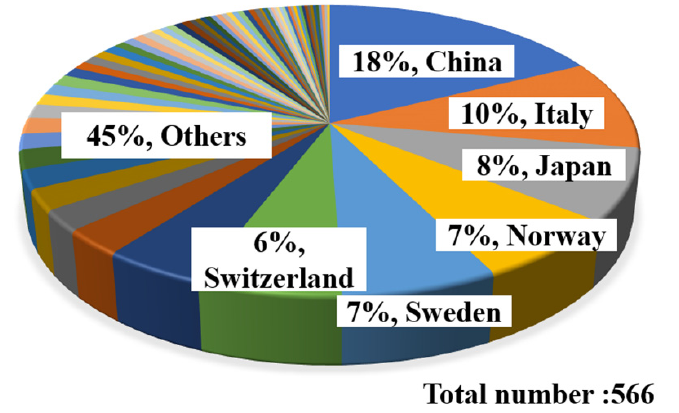
Figure 4. Distribution of underground powerhouses all over the world.